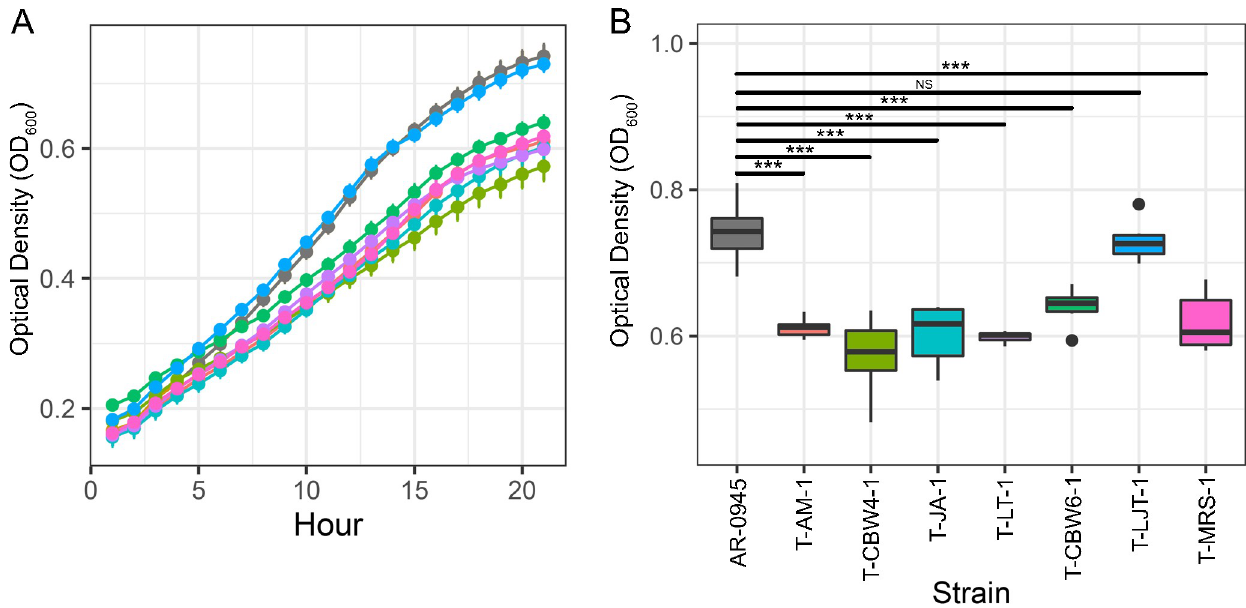
Fig 4. Impact of novel alleles in evolved cell lineages on growth rate compared to the ancestral AR-0945 strain. (A) Growth curves in GCP broth supplemented 1% Kelloggs solution were obtained by monitoring OD 600 over 21 hours (n = 6 replicates per strain). (B) Growth was significantly reduced in all strains compared to the ancestral at 21 hours, except for strain T-LJT-1. Significance between strains was determined using a one-way ANOVA followed post-hoc by Tukey’s HSD where ��� = p < 0.001 and NS = not significant.